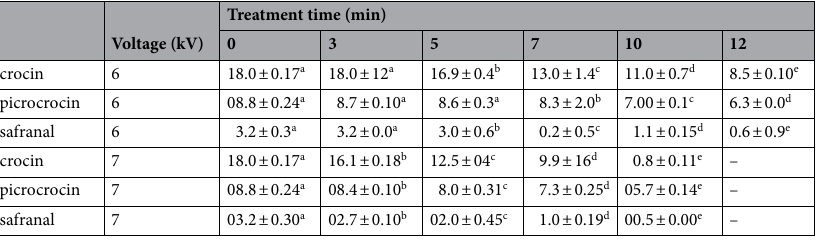
Table 3. The effect of the cold plasma treatment on safranal, crocin, and picrocrocin (%) of saffron. The Saffron is treated by cold plasma at different times (0, 3, 5, 7, 10, and 12 min) and different voltages (6 and 7 kV). The safranal, crocin, and picrocrocin were enumerated after treatment. abcdef means in the same row followed by different superscript letters are significantly different ( P < 0.05). Data represent the mean ± standard deviation of each sample (n =